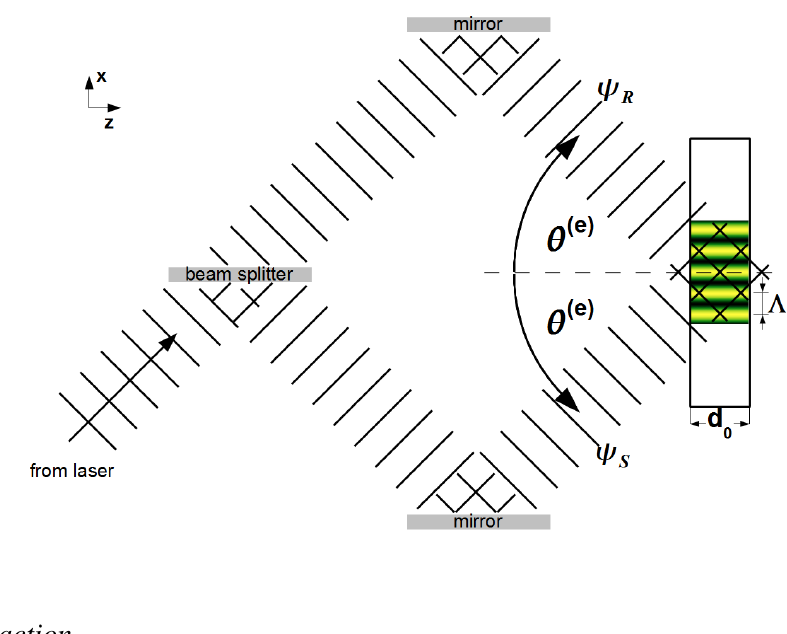
Figure 1. Sketch of the optical holography setup used to record diffraction